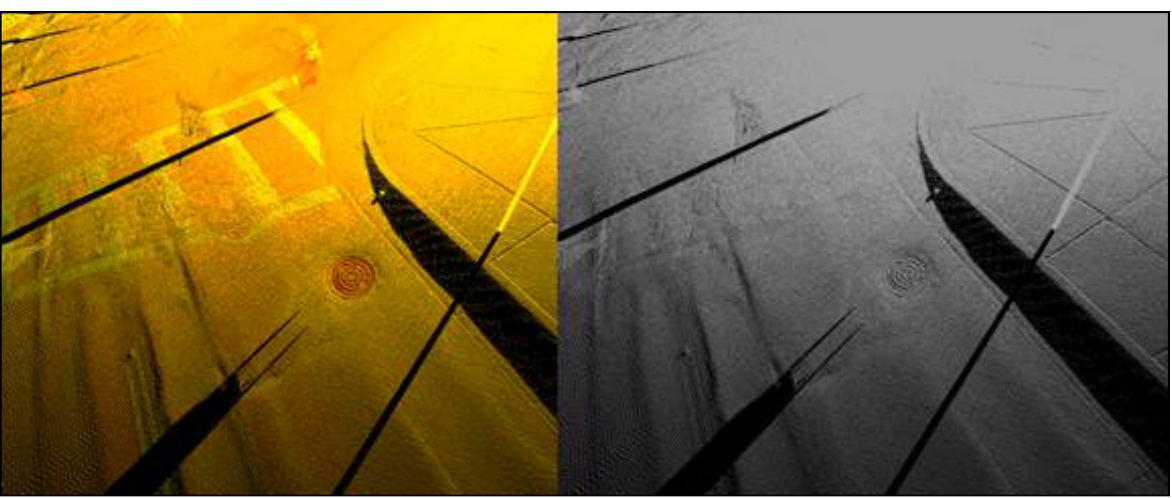
Figure 11. Painted street markings and manhole cover can be better distinguished in the intensity return colored image on the left (Data from a static